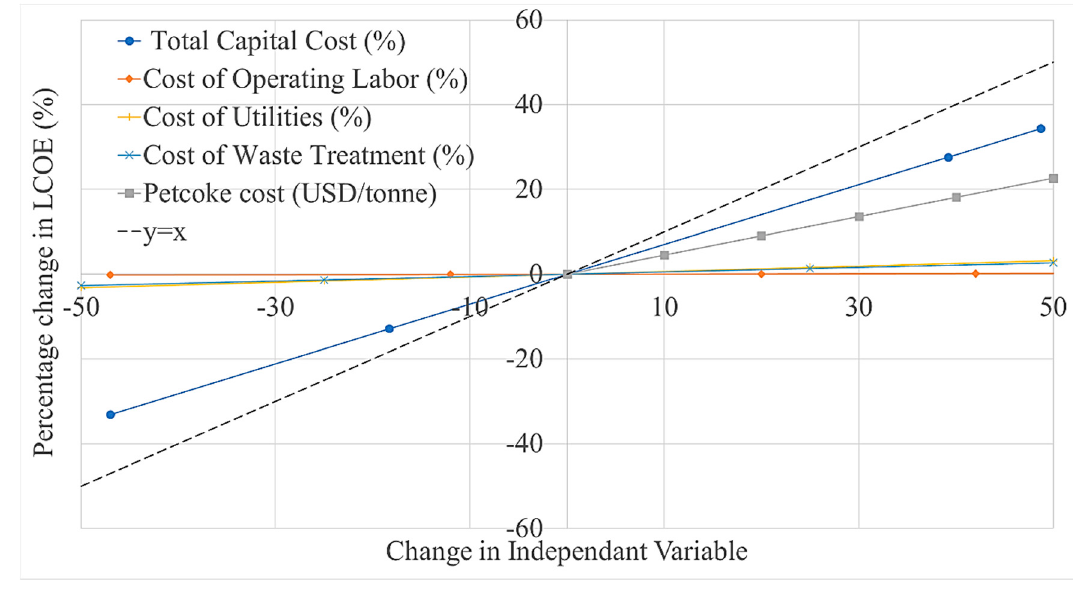
Figure 5. Sensitivity analysis for LCOE in the USA.